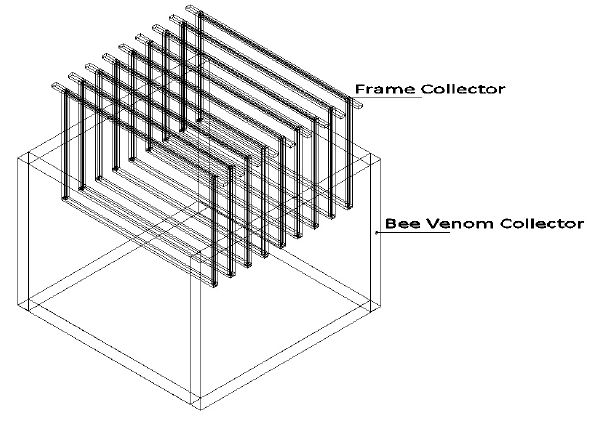
Figure 2. Collector with 10 Internal